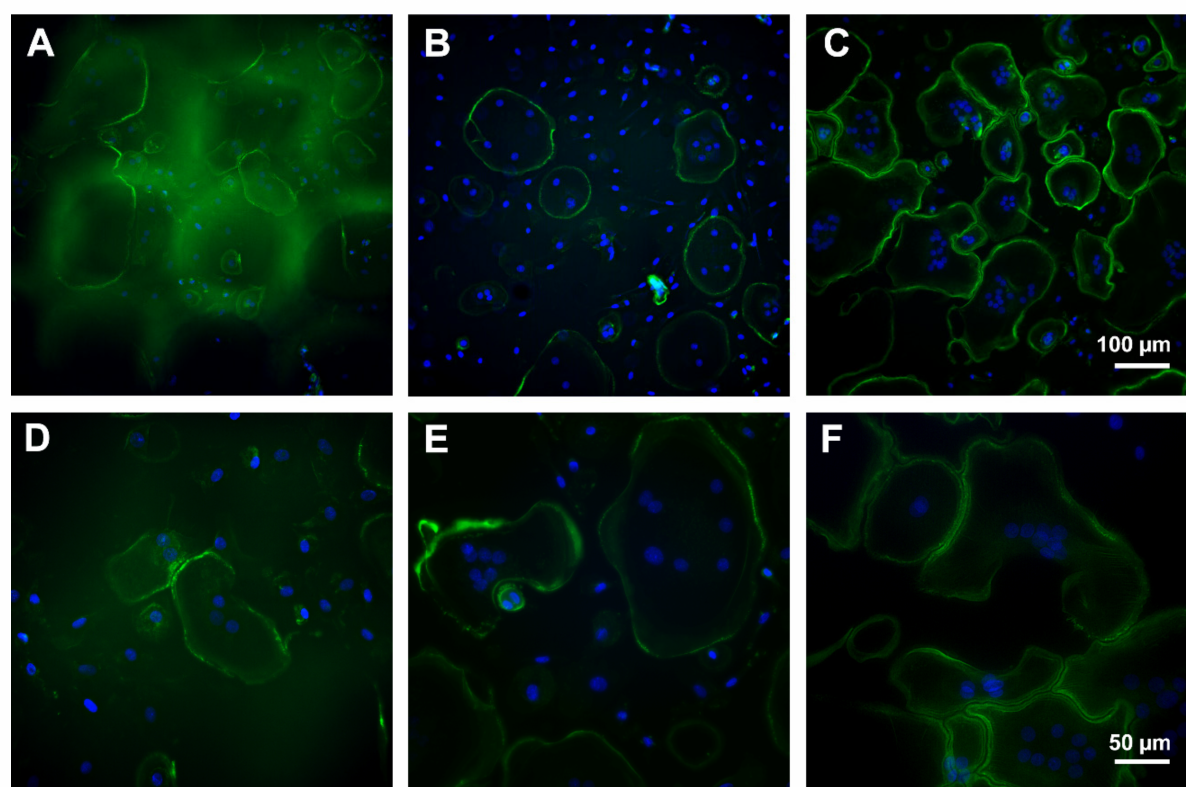
Figure 11. Immunofluorescence microscopy of osteoclasts after eight days of incubation on porous scaffold ( A , D ), compact scaffold ( B , E ), and cell culture plastic ( C , F ). Green: actin labelling, blue: nuclei. Scale bar of ( C ) is representative for ( A , B ) and of ( F ) for ( D , E